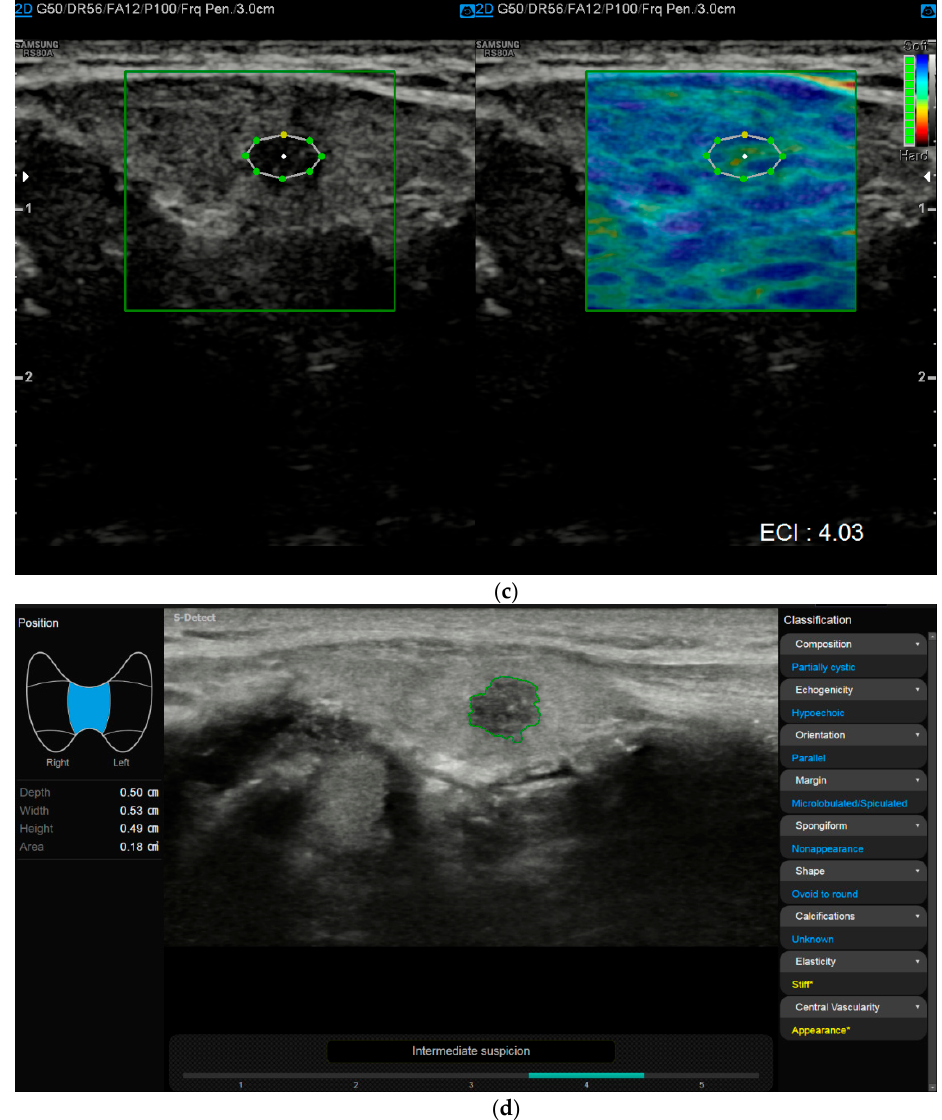
Figure 1. ( a ) . At B-mode Ultrasound (US), the lesion appeared round-shaped, hypoechoic with irregular margins (EU-TIRADS 5). ( b ). At color–Doppler US evaluation, the lesion showed no internal or peripheral vascularization (pattern I). ( c ). At US-Elastography (USE) evaluation, the lesion appeared stiff (ECI: 4.03). ( d ). At S-Detect evaluation, the lesion suggested intermediate suspicion of malignancy (TIRADS 4). Finally at histology it was identified as a papillary carcinoma.